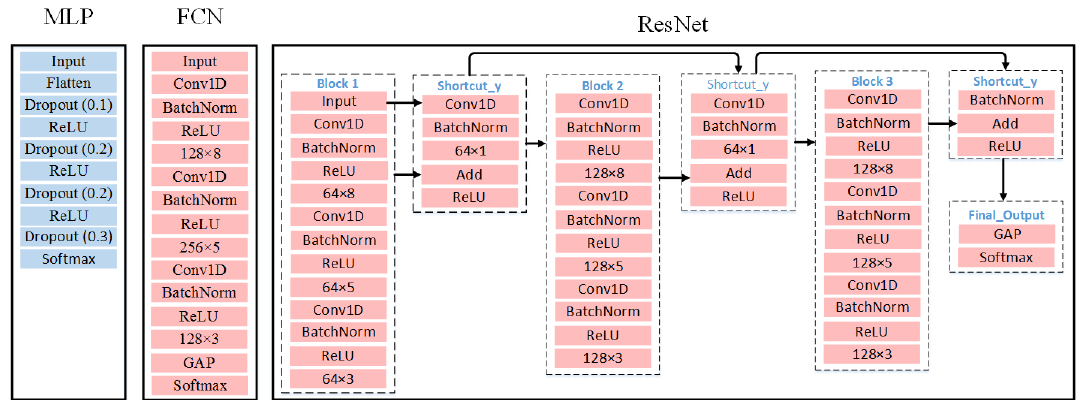
Figure 5. Network structure and hyper-parameter setting of deep learning classifiers. MLP = Multi-Layer Perceptron; FCN = Fully Convolutional Network; ResNet = Residual Network; ReLU = Rectified Linear Unit; GAP = Global Average